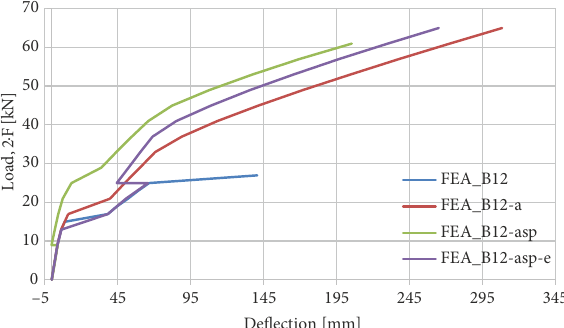
Fig. 2. External load vs deflection, curves predicted numerically. Reinforcement 4 ∅ 12